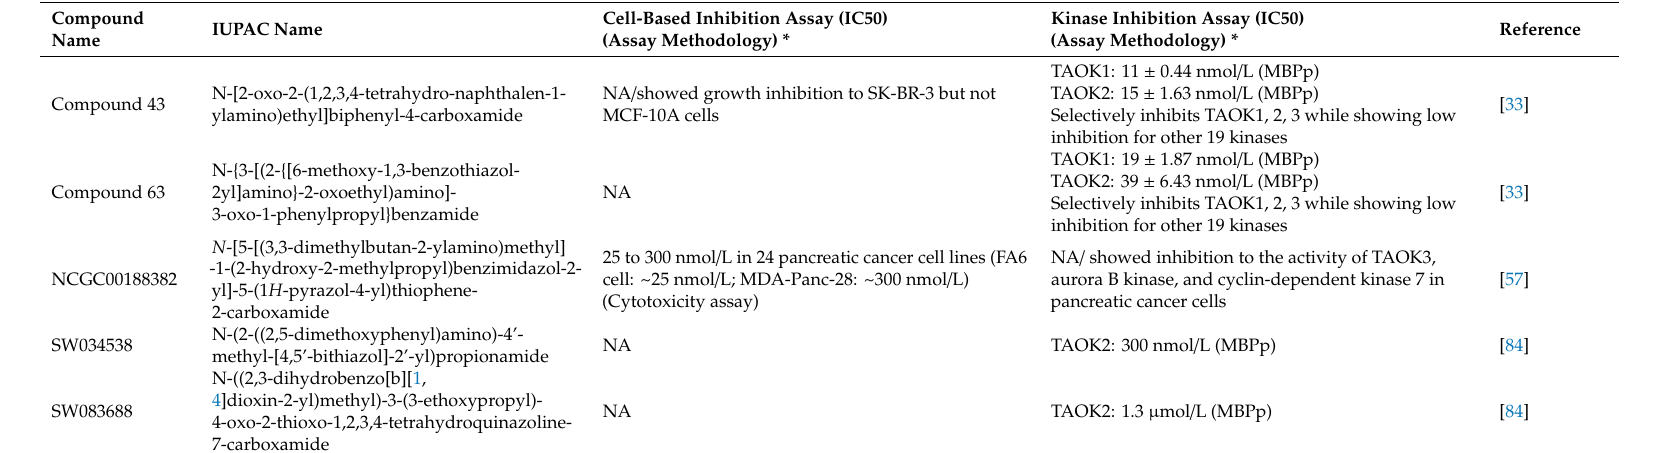
Table 1. Characteristics of currently available TAOK